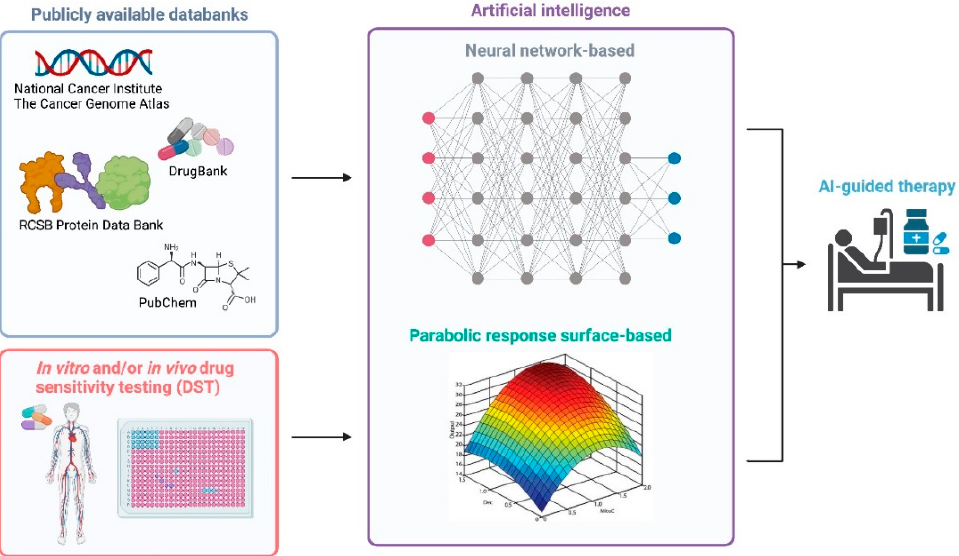
Figure 2. Identification of personalised therapy therapy using artificial intelligence in cancer. Overall framework for the identification of targeted therapy through network-based machine learning. Multidisciplinary databases and drug sensitivity testing (in vitro and in vivo) are used as inputs to train the machine learning model. Parabolic response surface-based map is reproduced with permission from Dr. Edward Chow [56]. This figure is created in BioRender.com (Available online: https://biorender.com/, accessed on 25 February